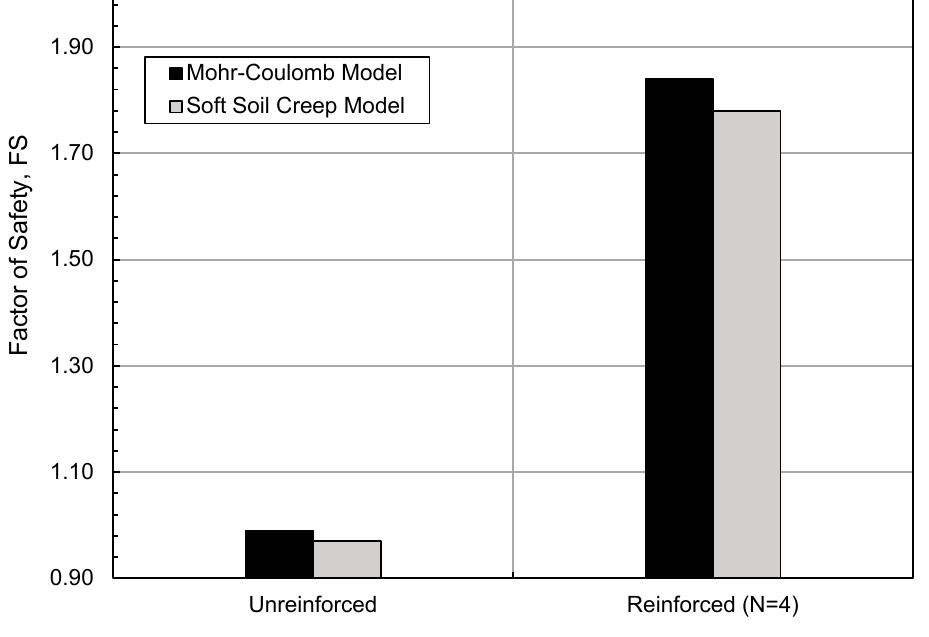
Figure 19. FS values obtained from different material models. Table 13. Analysis results for different material models (N =